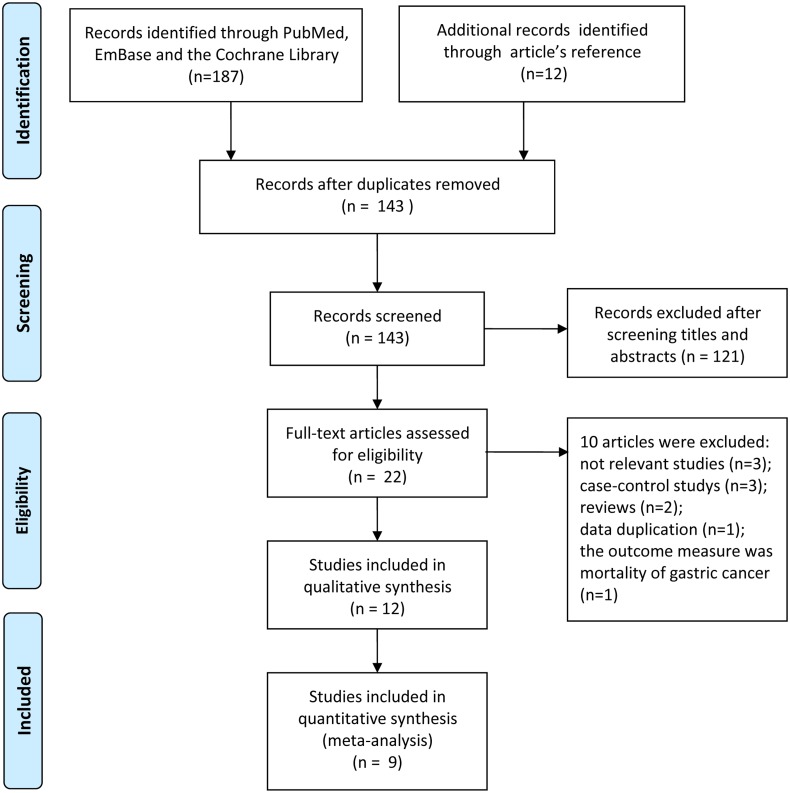
A flowchart identifying the studies that were included in the meta-analysis.